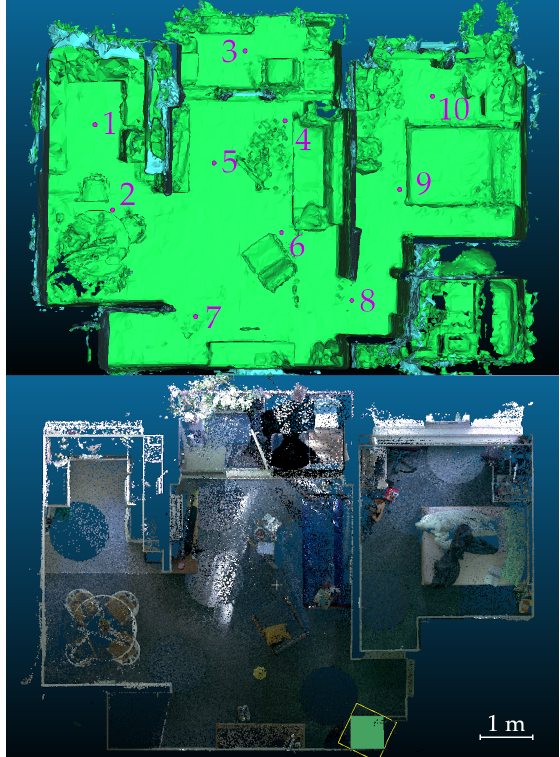
Figure 3. Models of the testing site. Top: a polygonal mesh model created with the Microsoft HoloLens (1 st gen) with testing locations marked. Bottom: a LiDAR point cloud with the cubes used for retrieval success rate